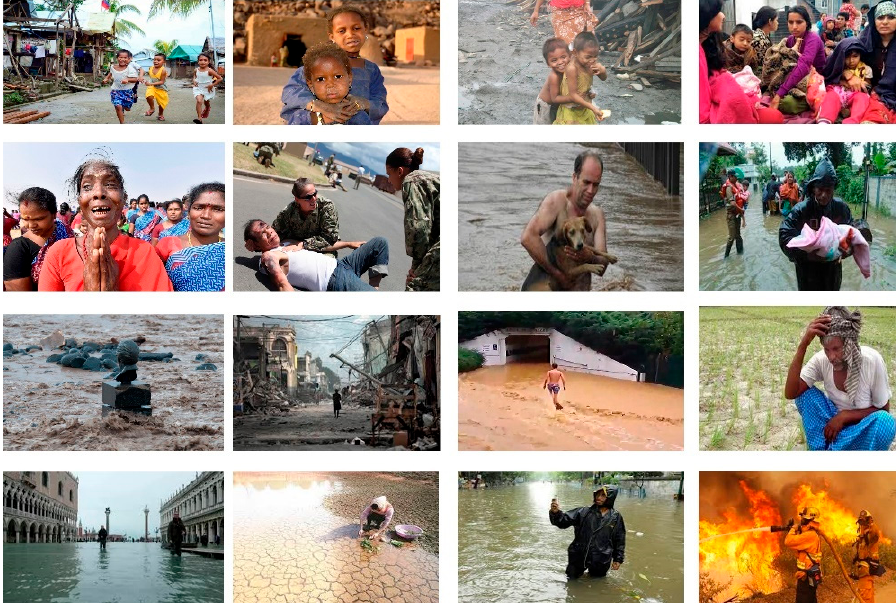
Table 2. Comprehensive spectrum of human emotions and corresponding actions utilized during the stage of crowdsourcing.